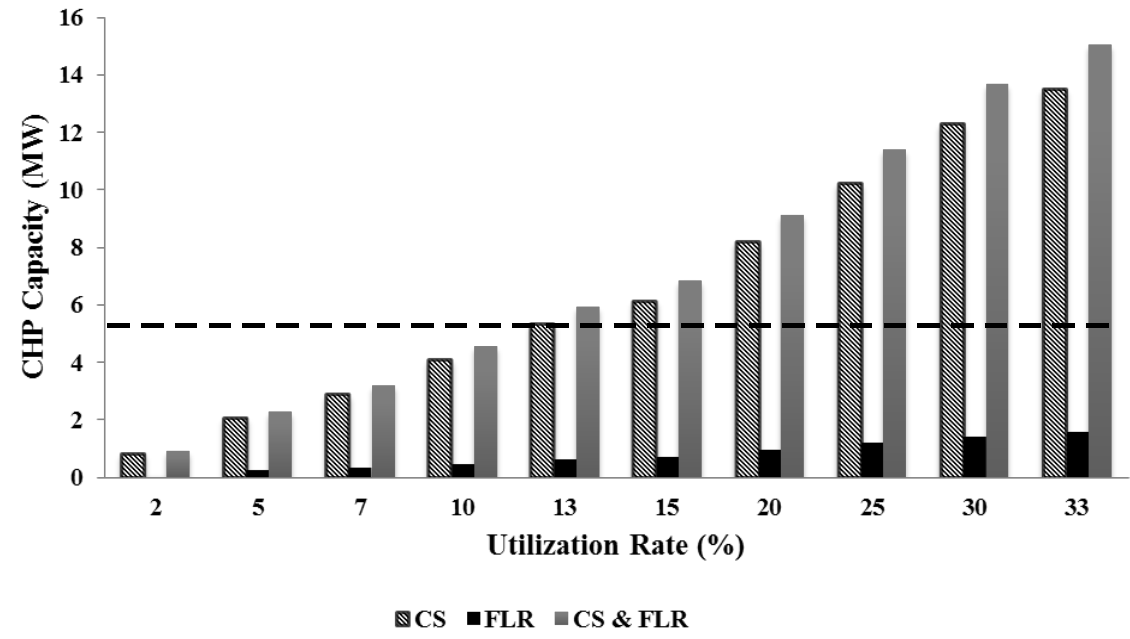
Figure 3. The capacities of the CHP plant Washington county calculated based on different utilization rates (%) of biomass feedstock. “---” Represents the existing capacity of the CHP plant in Washington county (5